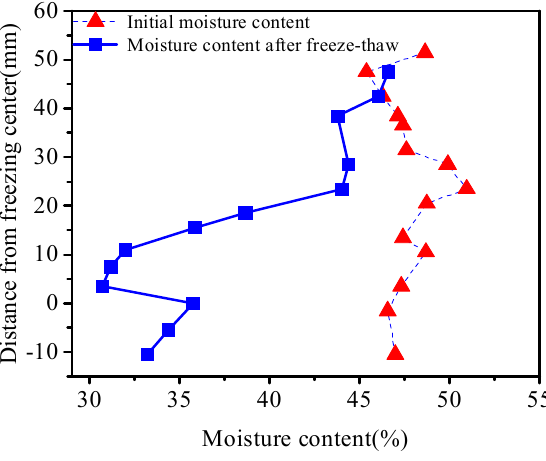
Figure 10. Change of water content.